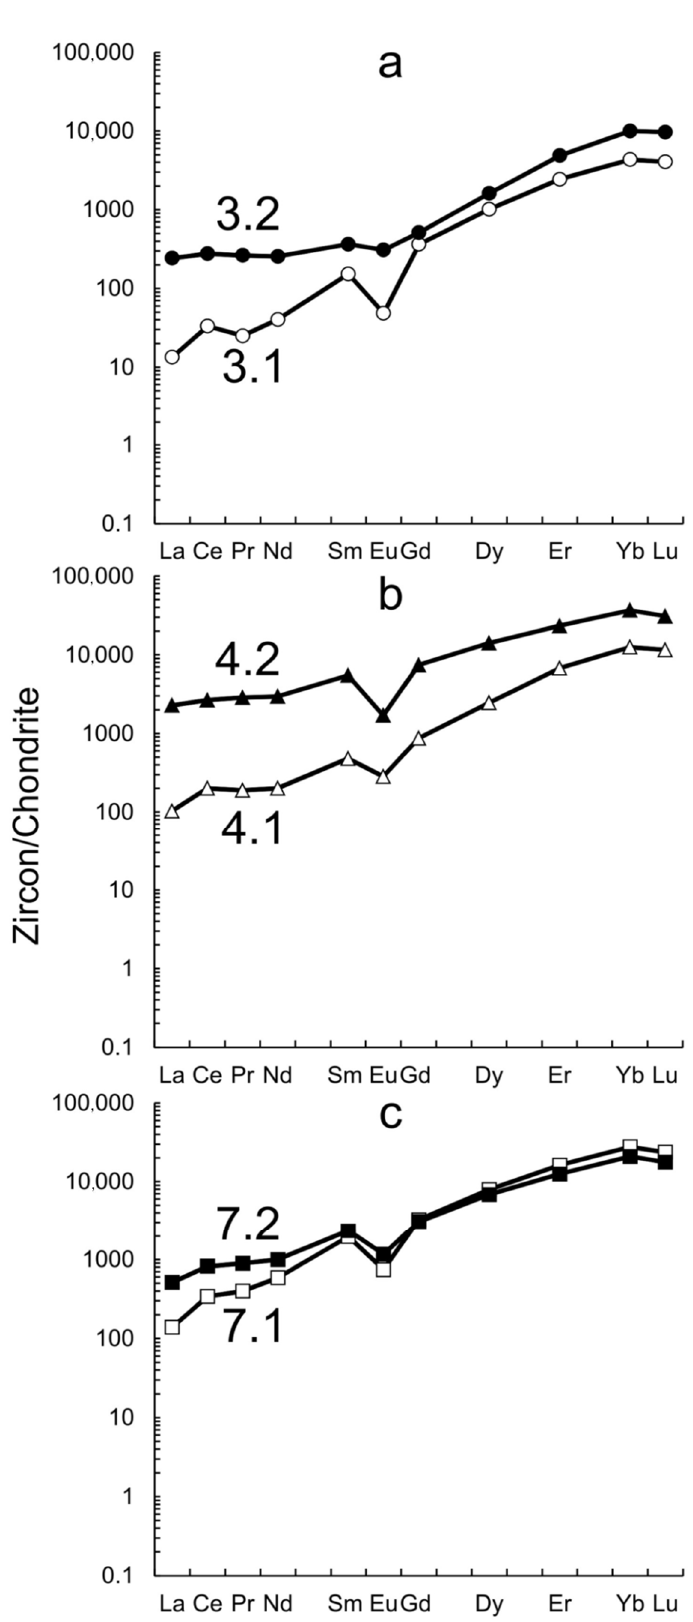
Figure 7. REE pattern for zircon grains from sample DV-27/04 in central zones (open circles, triangles and squares on graphs ( a – c ) and in marginal zones (filled symbols).